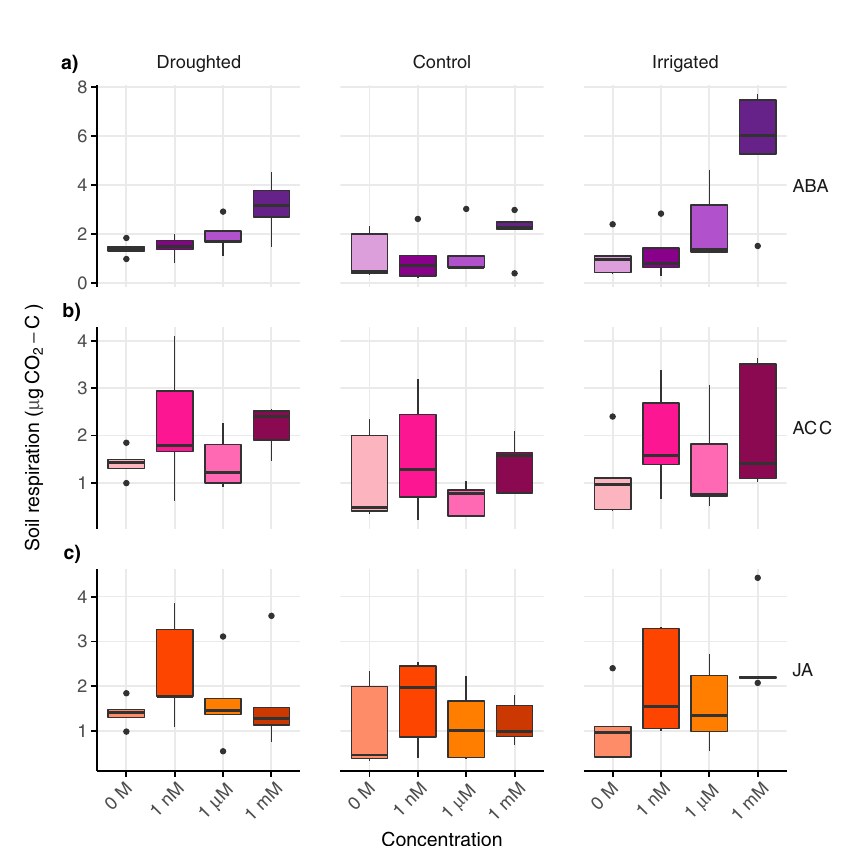
Fig. 1 Respiration rates (CO 2 ef fl ux) following phytohormone additions to soils from long-term climate change treatments. Soils collected from control, droughted and irrigated plots in the Buxton Climate Change Impacts Study were incubated for 6 h with addition of a abscisic acid (ABA), b 1-aminocyclopropane-1-carboxylic acid (ACC) or c jasmonic acid (JA) at three concentrations compared to procedural controls (concentration = 0 M); boxes denote the 25th and 75th percentiles, and median lines are given for n = 5 replicates based on independent fi eld plots; whiskers indicate values up to 1.5× the interquartile range and dots indicate